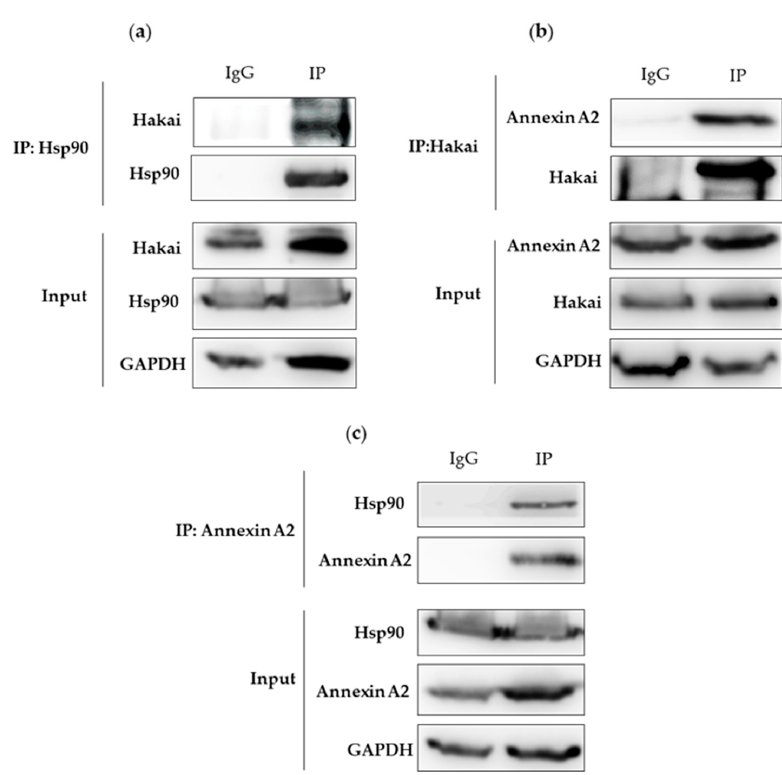
Figure 2. Hakai, Annexin A2, and Hsp90 interact with other: The whole cell extracts of HCT116 cell line cells were prepared and subjected to a co-immunoprecipitation assay. Subsequent western-blotting analysis was performed by using Hakai, Annexin A2, or Hsp90 antibodies ( a ) Hakai is specifically detected in anti-Hsp90 immunoprecipitates. ( b ) Annexin A2 is specifically detected in anti-Hakai immunoprecipitates. ( c ) Hsp90 is specifically detected in anti-Annexin A2 immunoprecipitates. GAPDH signal was used as protein loading control.